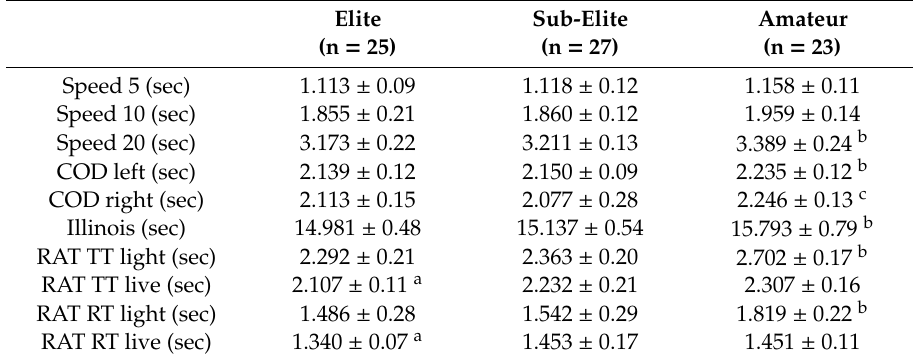
Table 2. Times for 5-, 10-, and 20-m sprint, CODS, and agility performance for the elite, sub-elite, and amateur soccer players (Means +